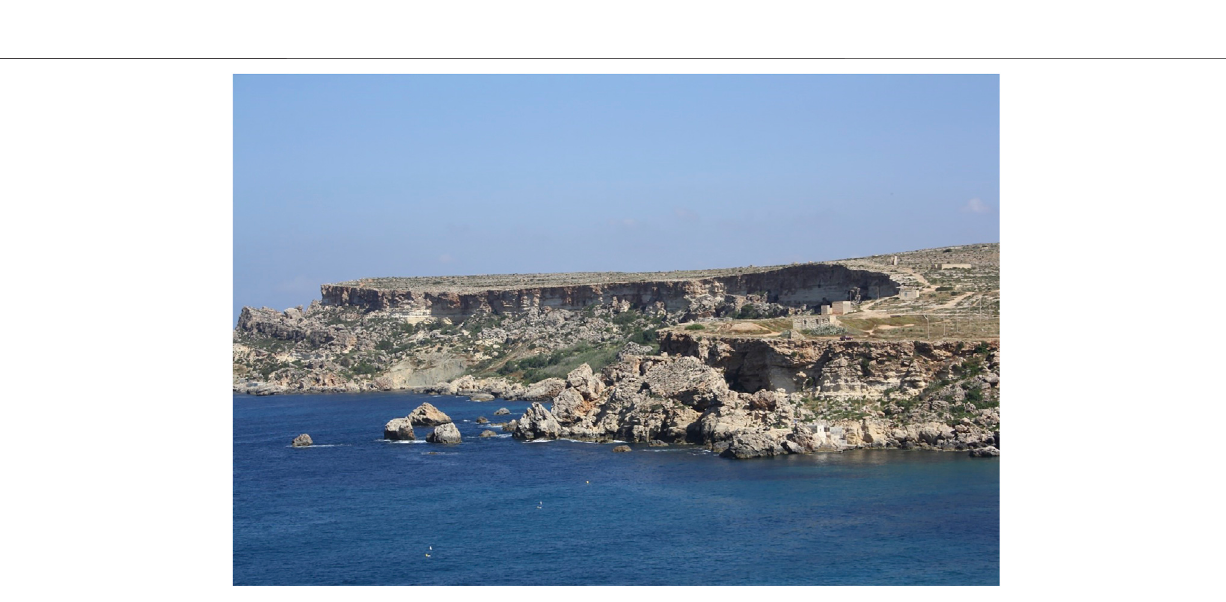
Frontiers in Earth Science |